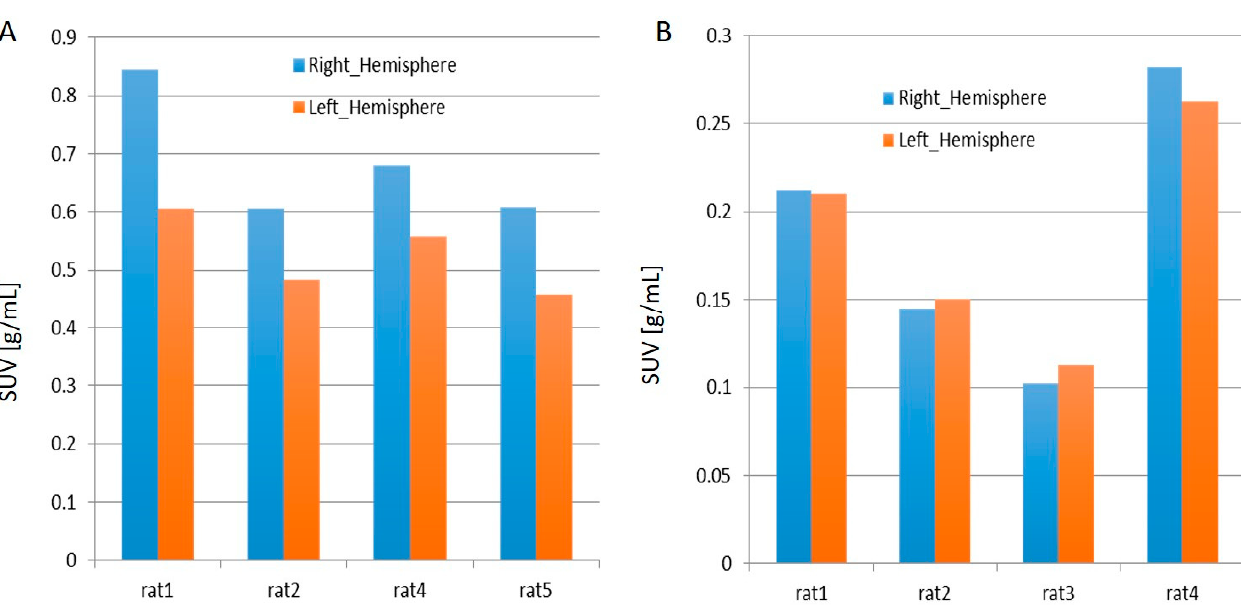
Figure 4. Average standardized uptake values (SUVs) for the last 30 min frames with ( A ) [ 11 C]PBR28 and ( B ) [ 18 F]fluma- zenil.